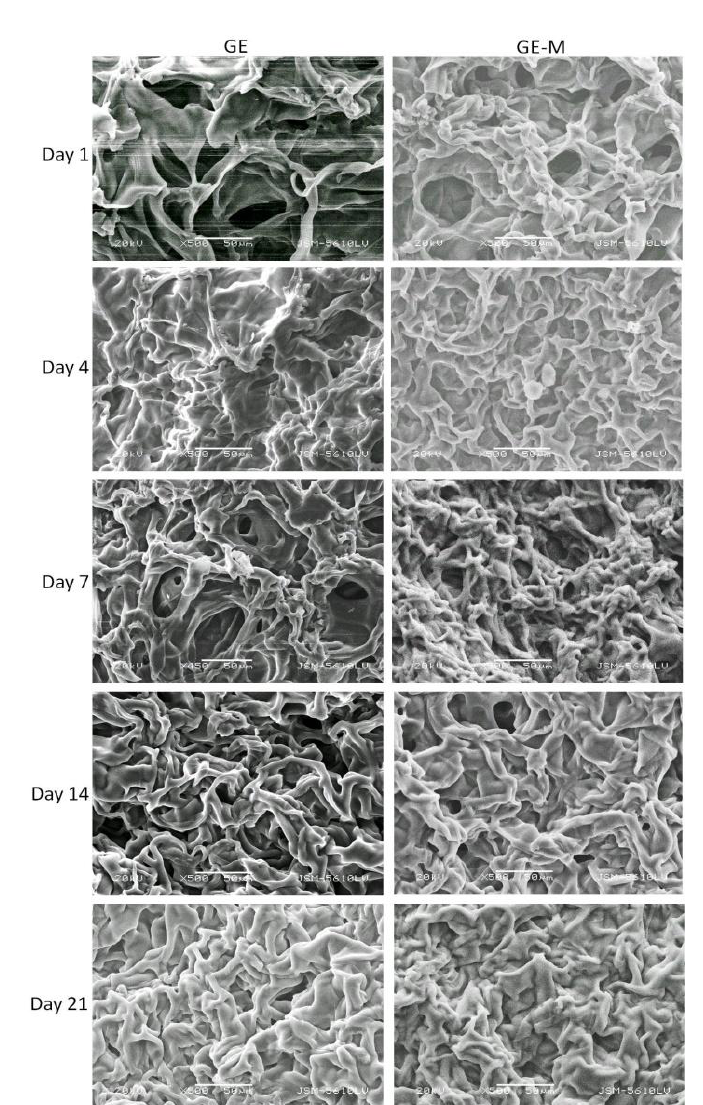
Figure 10. SEM of cellularized GE and GE-M scaffolds. No discernible cells on surface although scaffold becomes less porous over time. Scale bars at 50